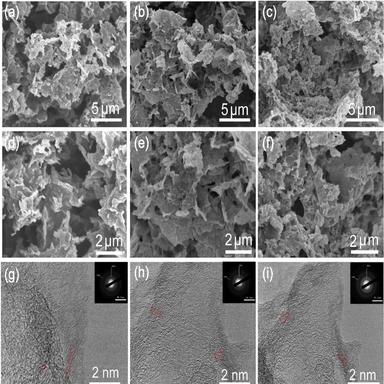
SEM images of (a, d) CHC-1, (b, e) CHC-2, and (c, f) CHC-3. HRTEM images and SADE patterns of (g) CHC-1, (h) CHC-2, and (i) CHC-3.